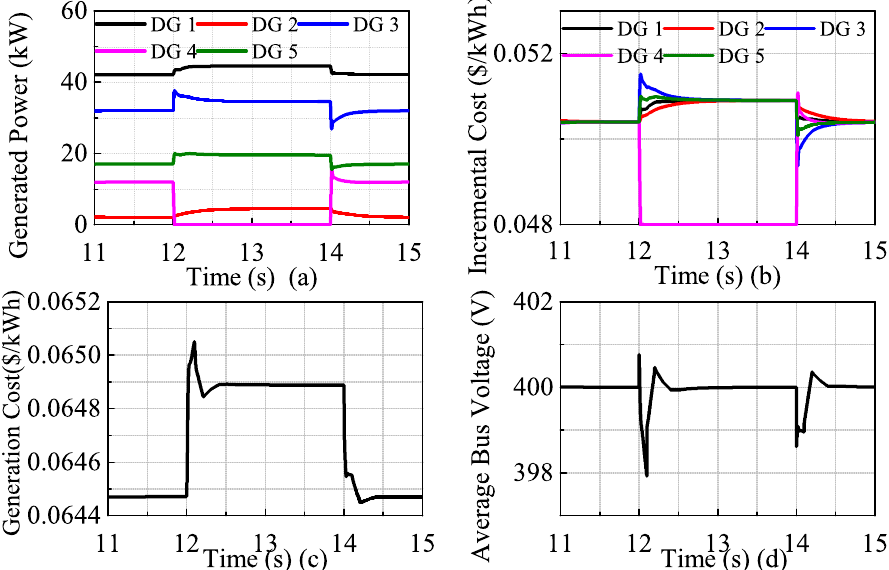
Figure 13. Performance of the proposed control strategy with a DG turned off. ( a ) Generated power of each DG. ( b ) Incremental cost of each DG. ( c ) Total generation cost of all the DGs. ( d ) Average bus voltage of the microgrid.